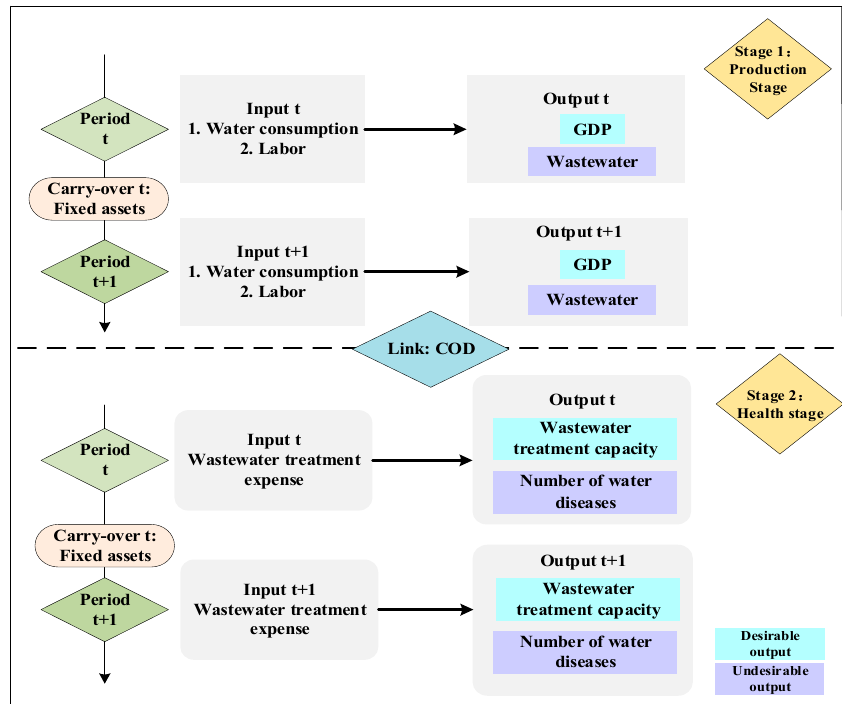
Figure 1. The modified undesirable dynamic network model.